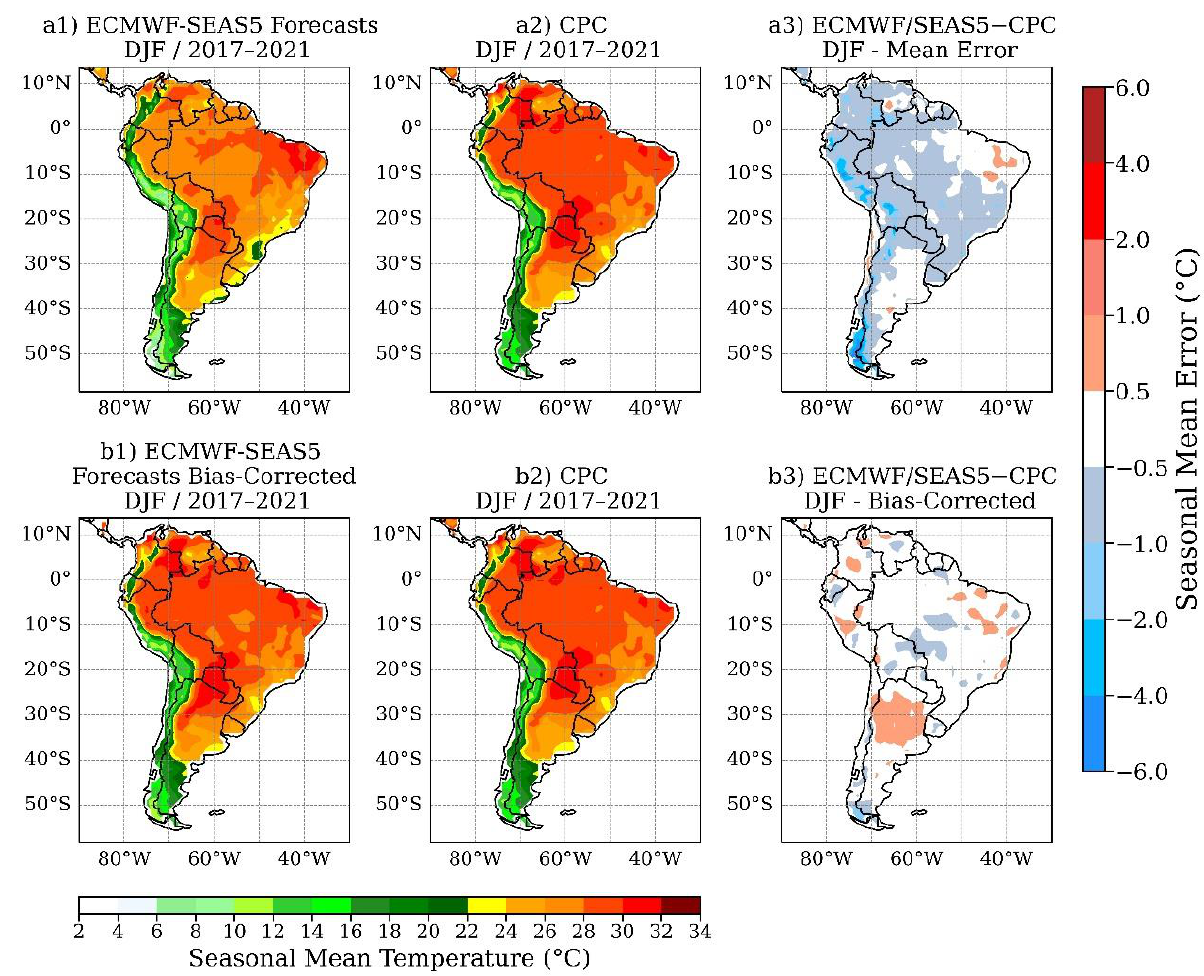
Figure 4. ECMWF-SEAS5 seasonal 2-m temperature (°C) forecasts for DJF from 2017 – 2021 without ( a ) and with ( b ) the simple bias correction.